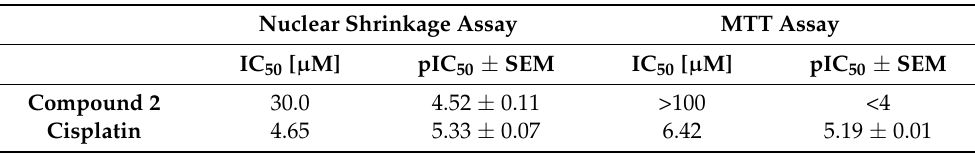
Table 3. IC 50 and pIC 50 for compound 2 and cisplatin in nuclear shrinkage and MTT